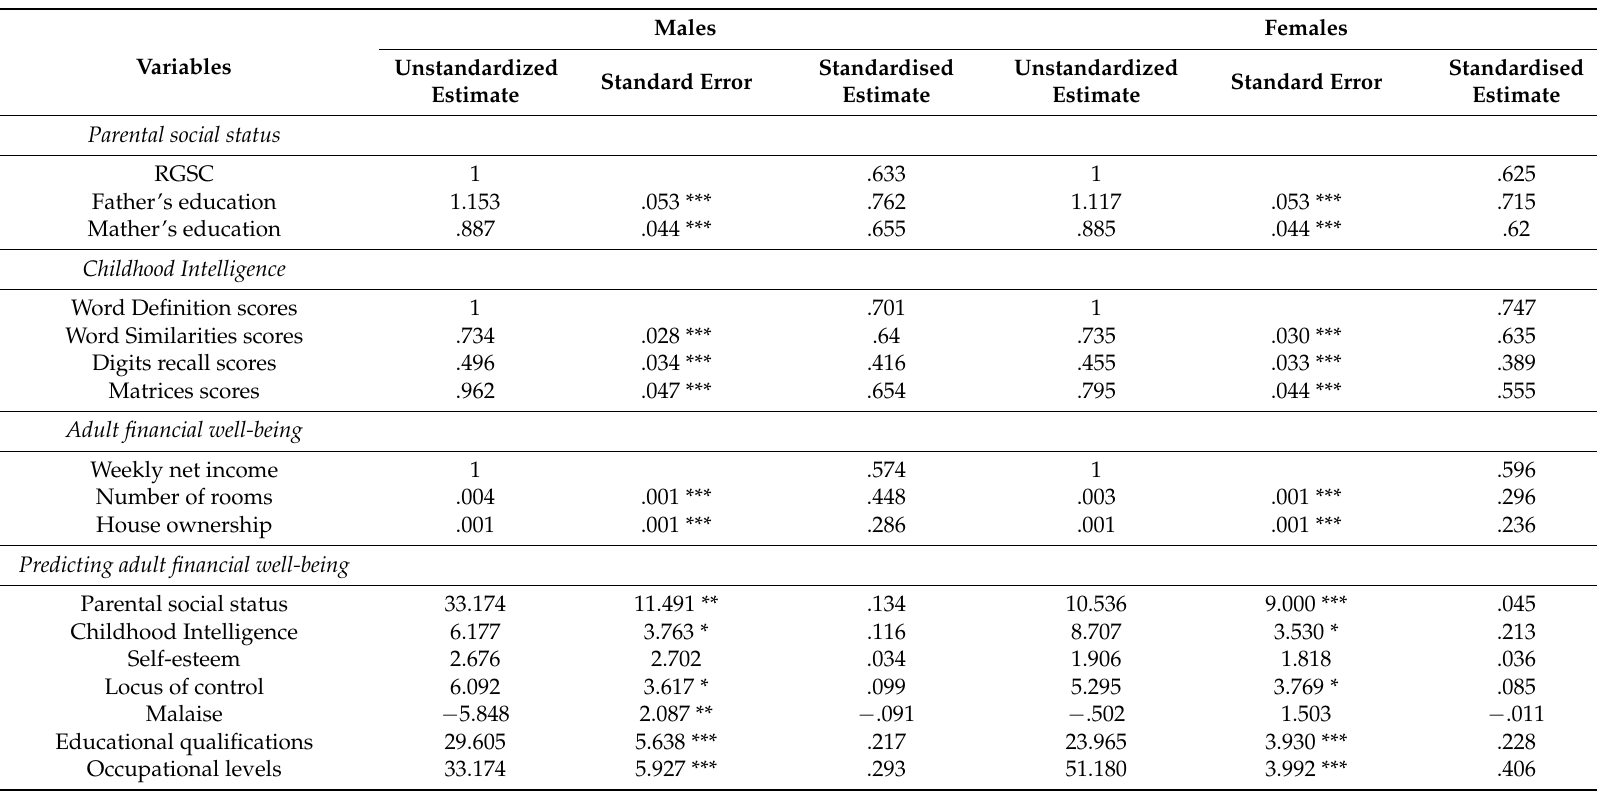
Table 2. Unstandardized estimate, standard error and standardised estimate of the latent and observable variables of SEM that predict adult financial well-being for male and female